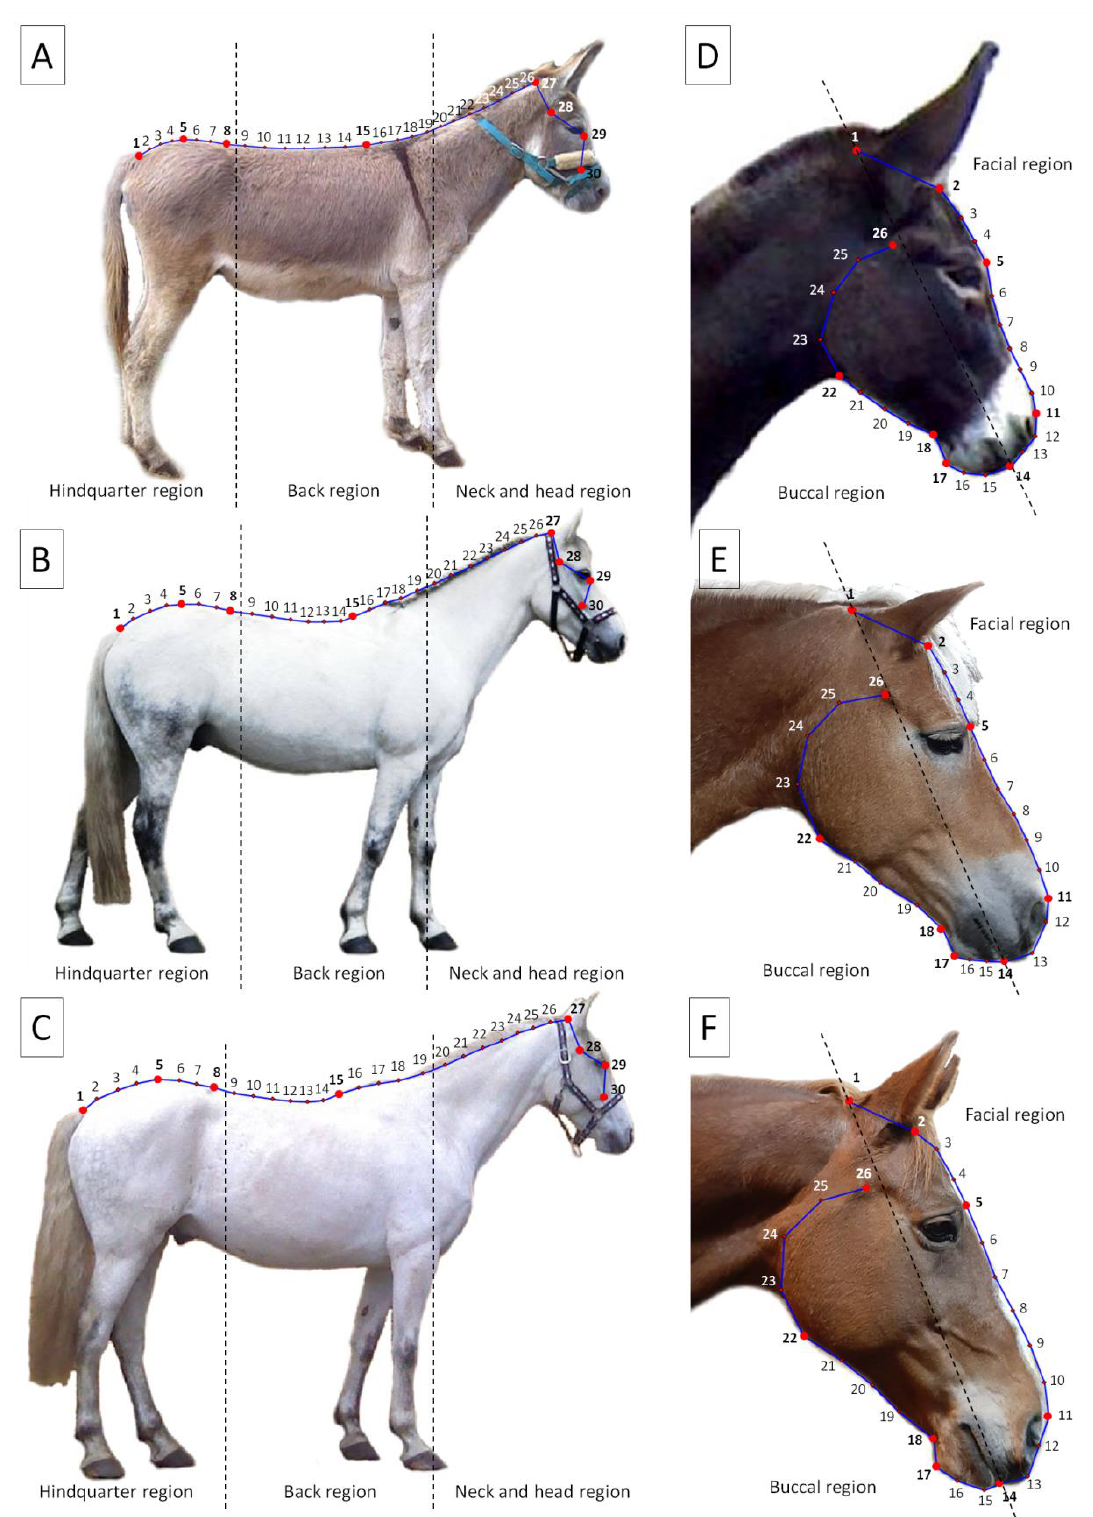
Figure 1. Examples of the digitalization of landmarks (LDs; marked with a big red point and bold font) and the sliding semilandmarks (SSLs; marked with a small red point) from photographs of donkeys ( A , D ), ponies ( B , E ), and horses ( C , F ). The blue curves were fitted to the shape of the dorsal profile ( A – C ) and the head ( D – F ). Dashed lines indicate the boundaries between regions.